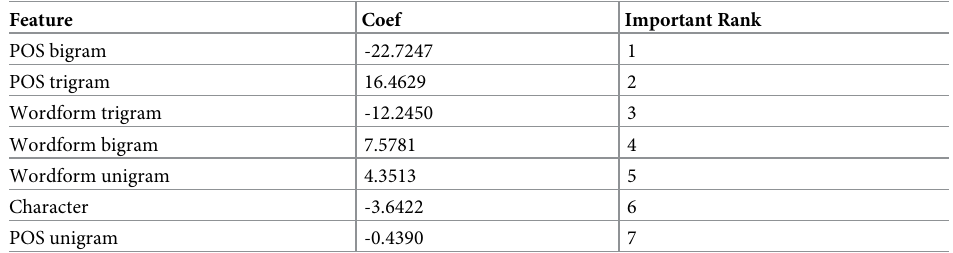
Table 4. Importance coefficient and ranking of features in LDA